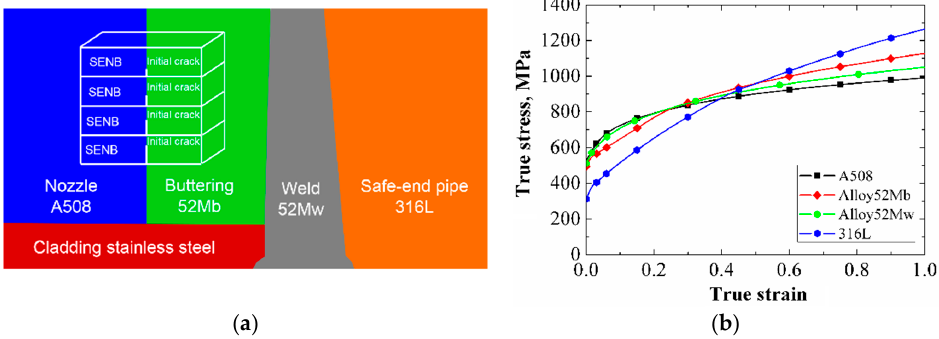
Figure 1. The dissimilar metal welded joint (DMWJ) ( a ) and the true stress-strain curves of the four materials composed of the DMWJ ( b ).